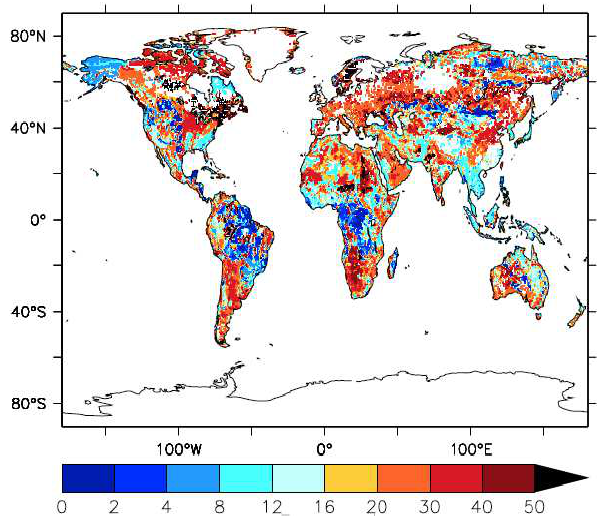
Fig. 3. Percent of soil area where clay mineralogy exists in the database.